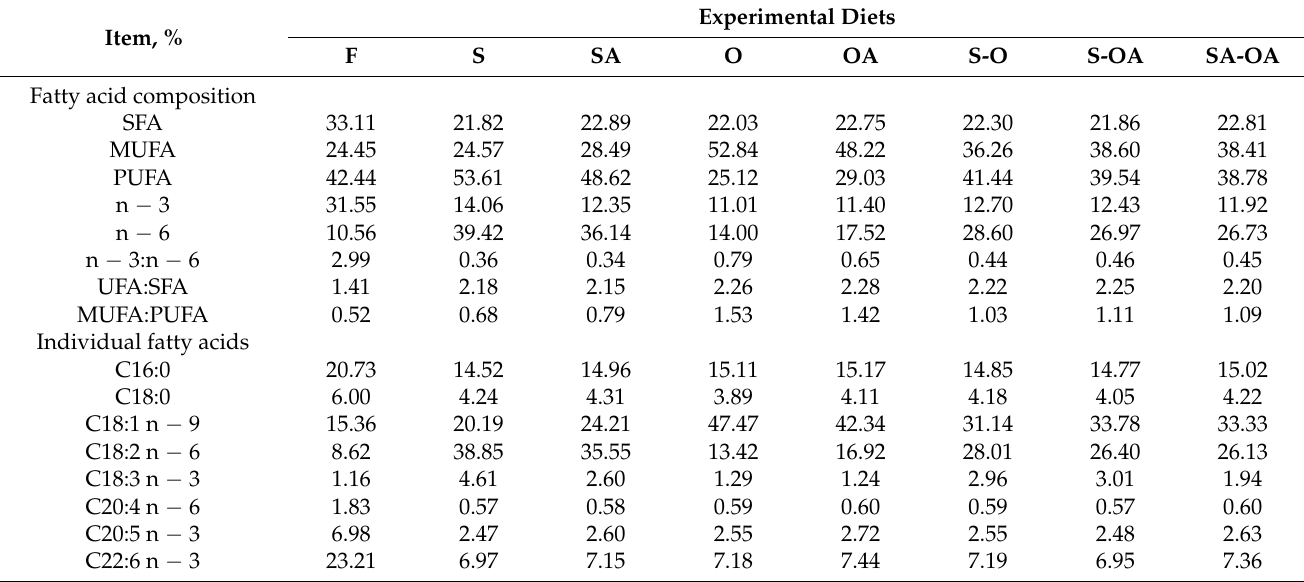
Table 3. Fatty acid profile of experimental